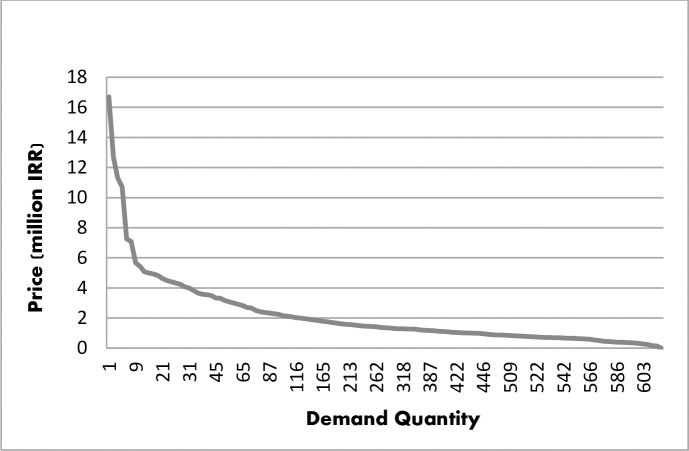
IUI demand curve.